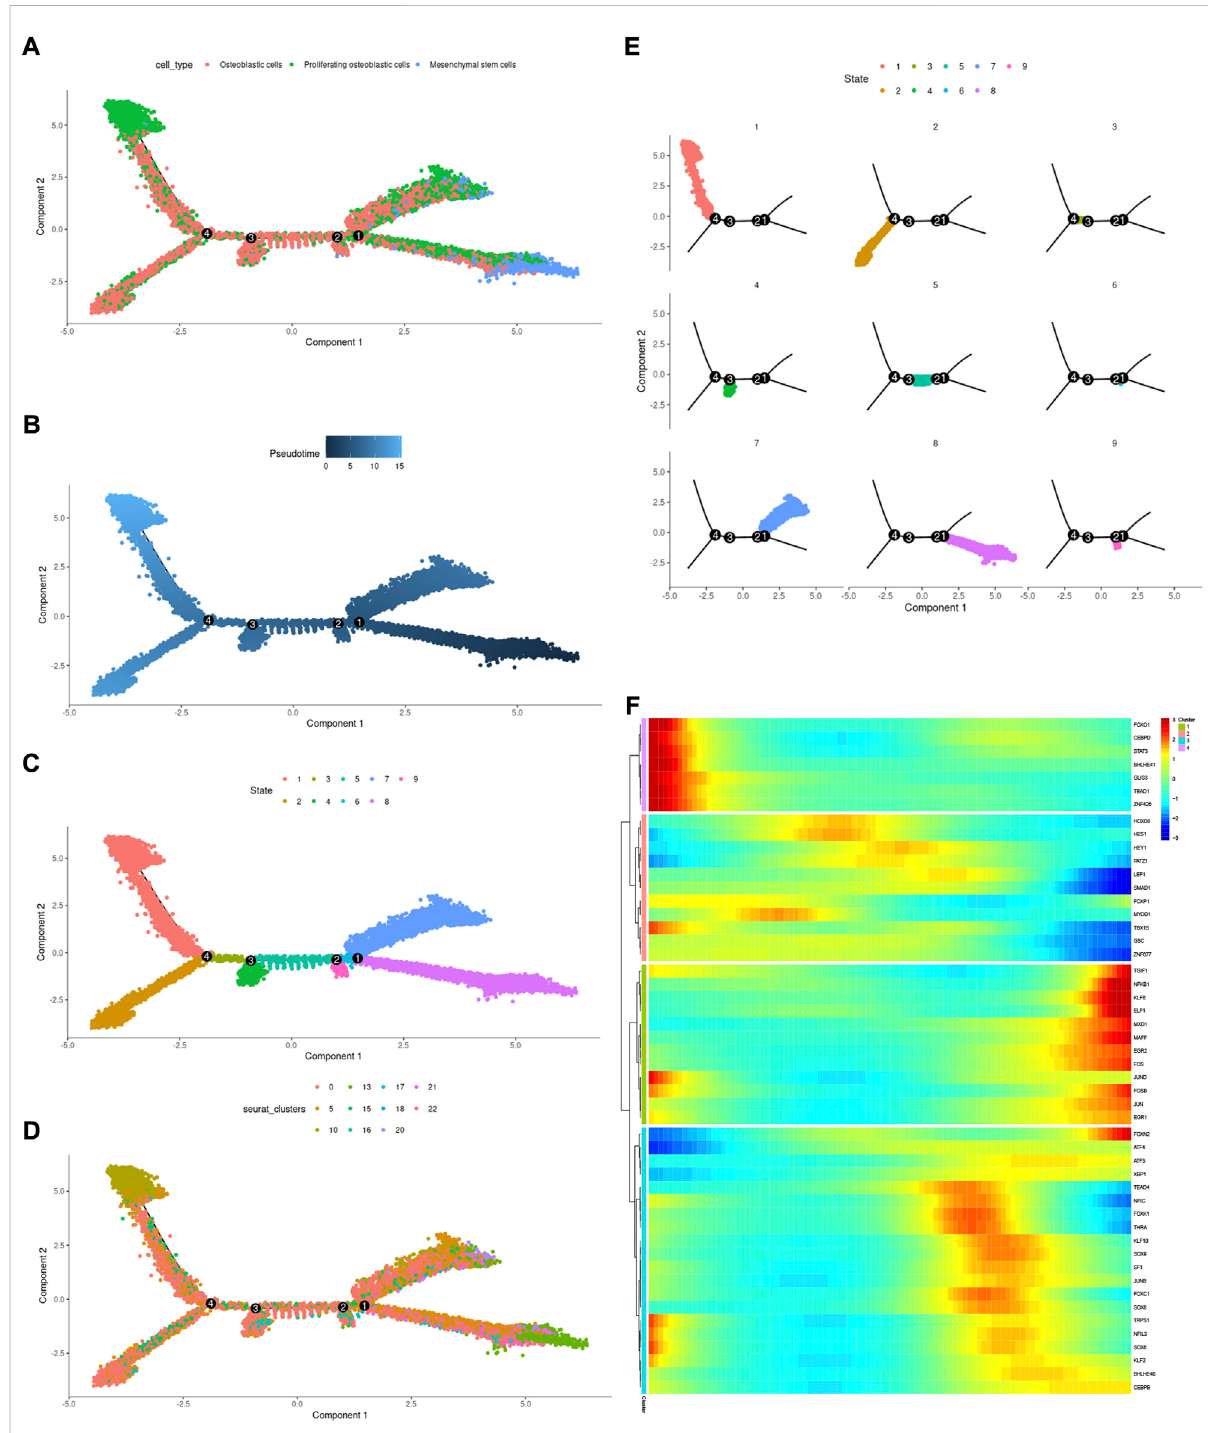
FIGURE 10 Trajectory analysis of mesenchymal stem cells, proliferating osteoblastic cells, and osteoblastic cells. (A – E) : trajectory plots showing the differentiationofthesecelltypes. (F) :heatmapdisplayingthescaledexpressionofdynamicgenesacrosstime.Therowsoftheheatmapre fl ectgenes exhibiting dynamic changes along the pseudotime, and these genes have been grouped into four categories based on their expression pattern over the